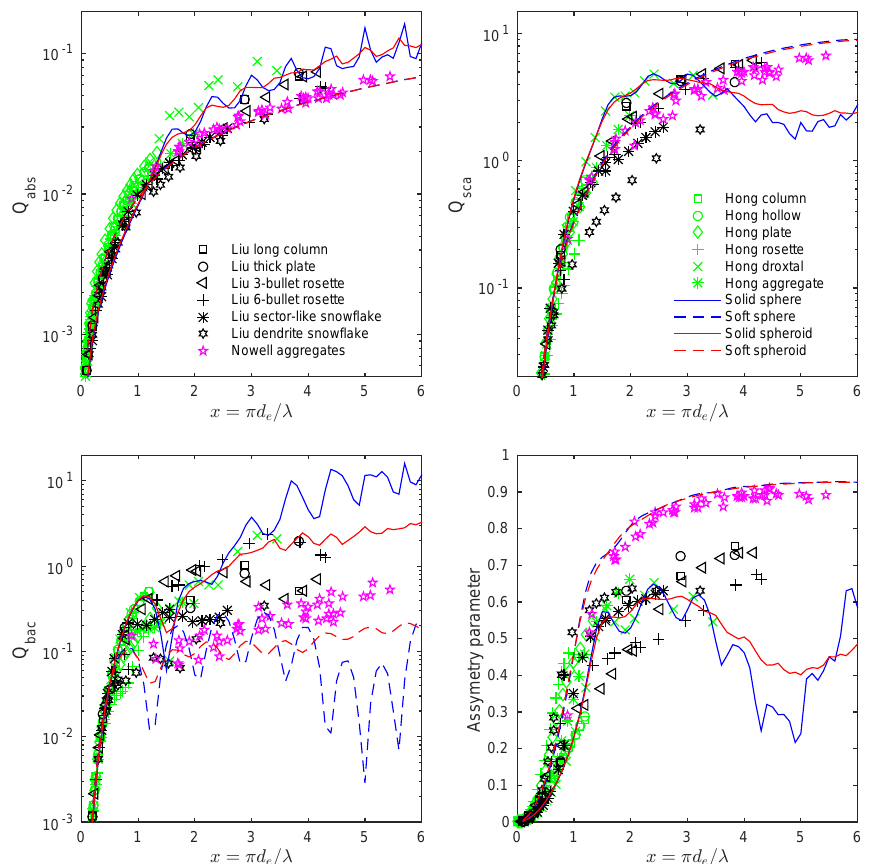
Figure 3. DDA-based single-scattering properties at 183GHz from the databases of Liu (2008), Nowell et al. (2013) and Hong et al. (2009). Absorption, scattering and backscattering efficiencies (Eq. 10) and asymmetry parameter are displayed. The combined legends are valid for all panels. The figure includes also data of solid and soft spheres and spheroids, with refractive index following Mätzler (2006). The soft particles have an air fraction of 0.75, with the effective refractive indices derived by the MG ai mixing rule. The spheroids are oblate with an aspect ratio of 1.67. All results are valid for 183GHz and 243K except those of Nowell et al. (2013) for